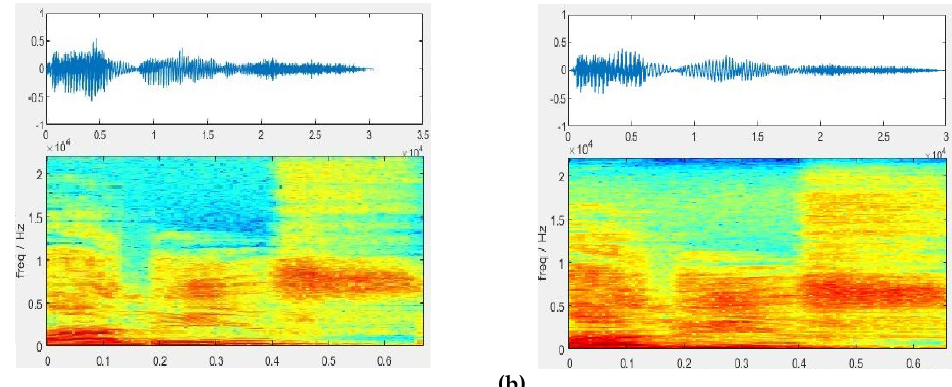
Figure 4. Time and frequency representation of audio file: ( a ) without data augmentation, ( b ) with augmentation.